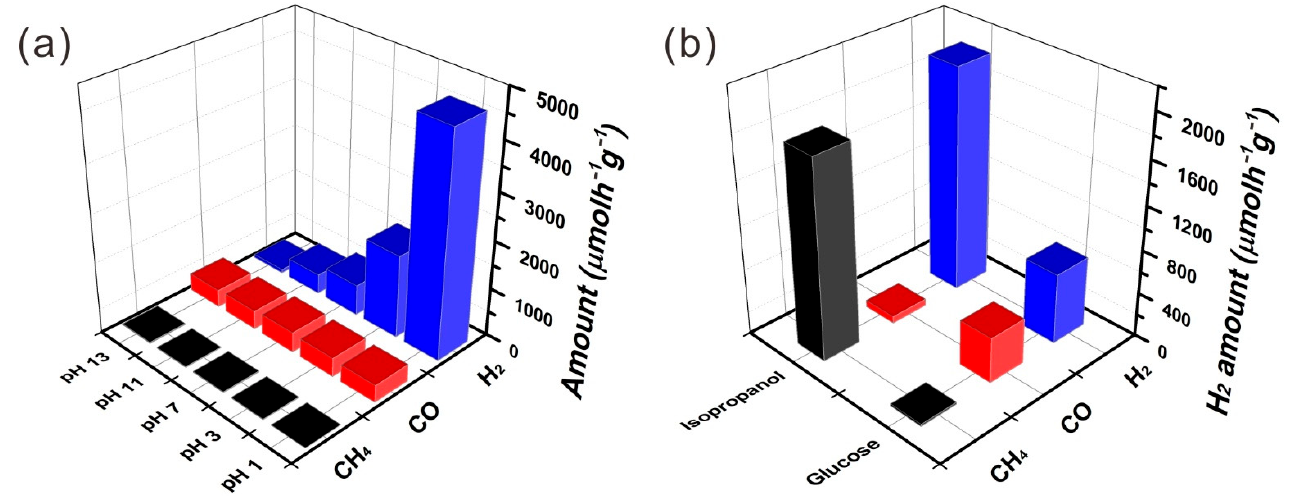
Figure 6. ( a ) Photocatalytic gas production with different pHs; ( b ) comparison of the gas production between glucose and isopropanol. Reaction conditions: 10 mg photocatalyst, 15 mL 2 g/L aqueous solution with glucose or isopropanol, and a 300 W xenon lamp.